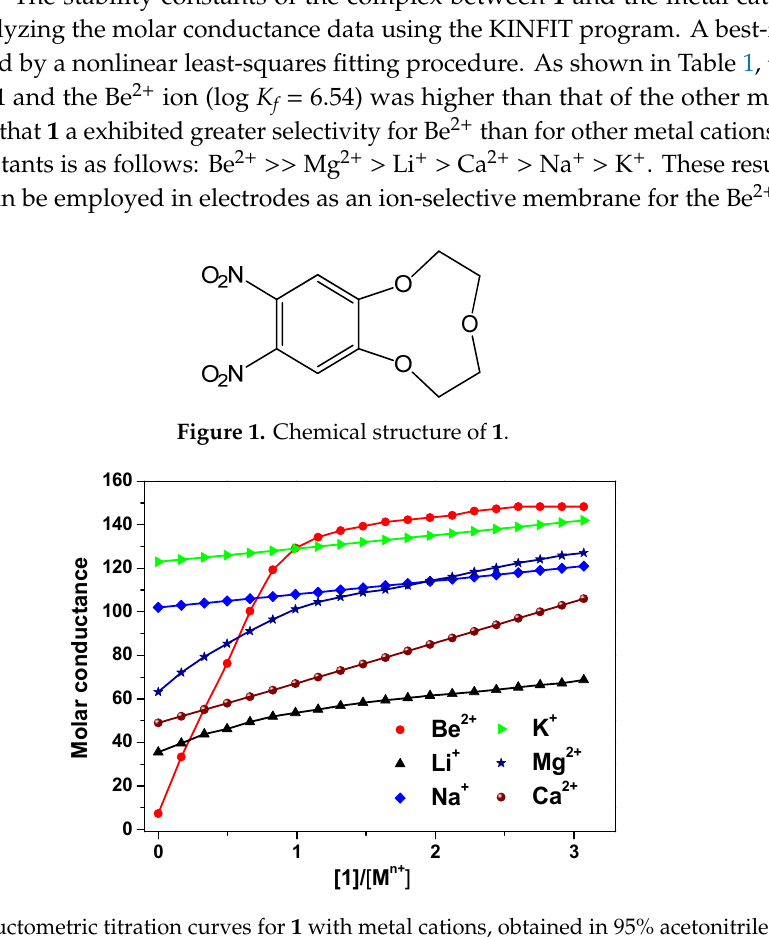
Figure 2. Conductometric titration curves for 1 with metal cations, obtained in 95% acetonitrile-DMSO Table 1. Log K f values of binary mixtures of 1 complexes with different cations in 95% AN-DMSO.